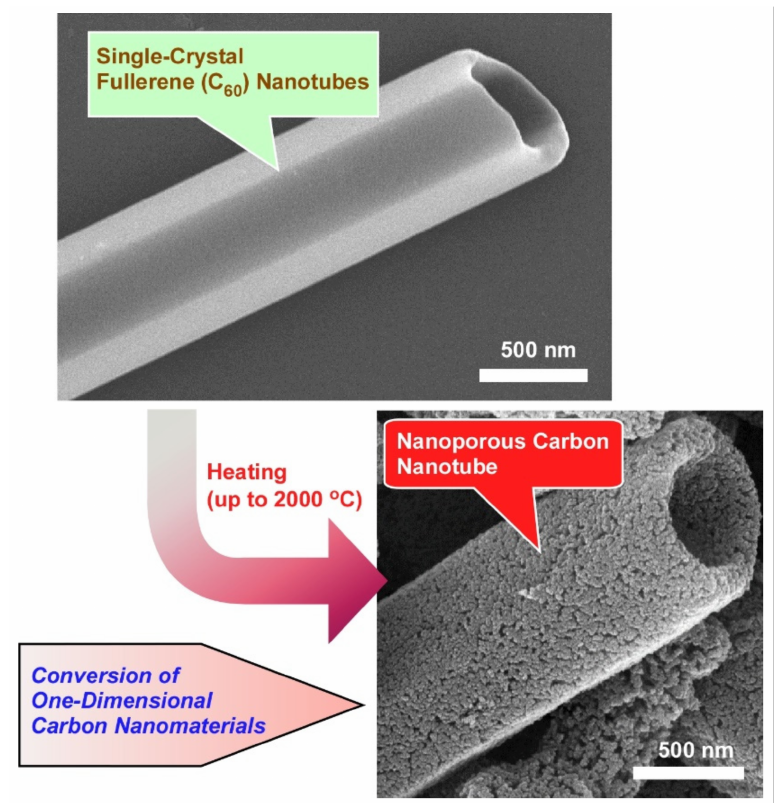
Figure 6. Conversion of one-dimensional single-crystal fullerene (C 60 ) nanotubes to nanoporous carbon nanotubes by heating directly at very high temperature (up to 2000 ◦ C) in